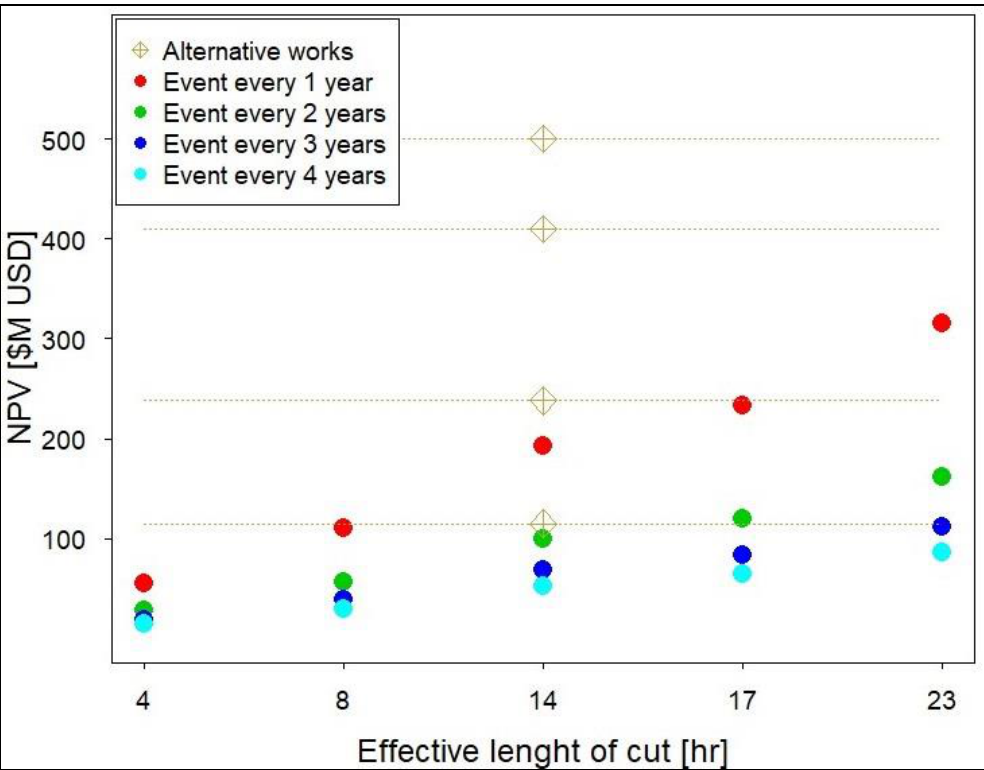
Figure 4. Net present value (NPV) infrastructure costs vs compensation, r = 6%.